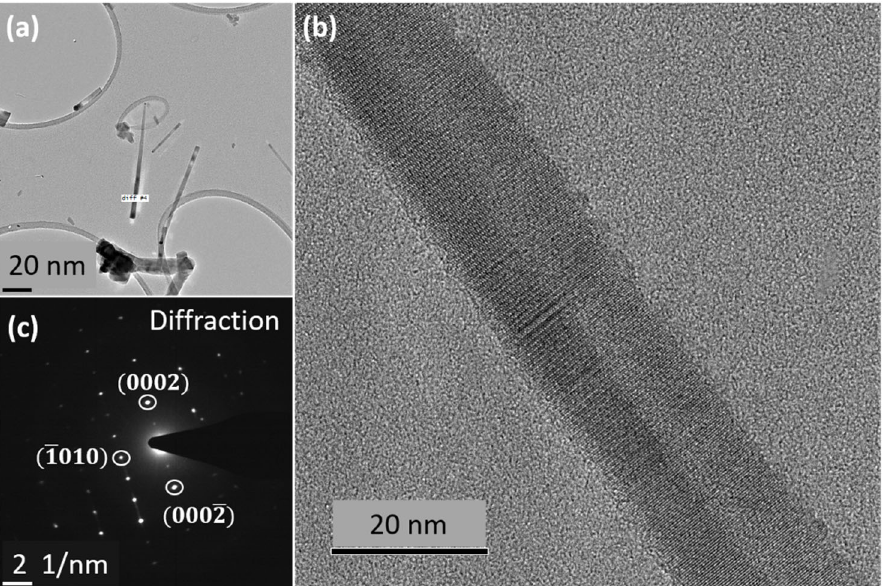
Figure 11. ( a ) bright-field TEM image of ZnS NWs (high supersaturation), ( b ) the HRTEM image of NW revealing a pure WZ phase, ( c ) SAED pattern of the NW presenting WZ-like footprint.